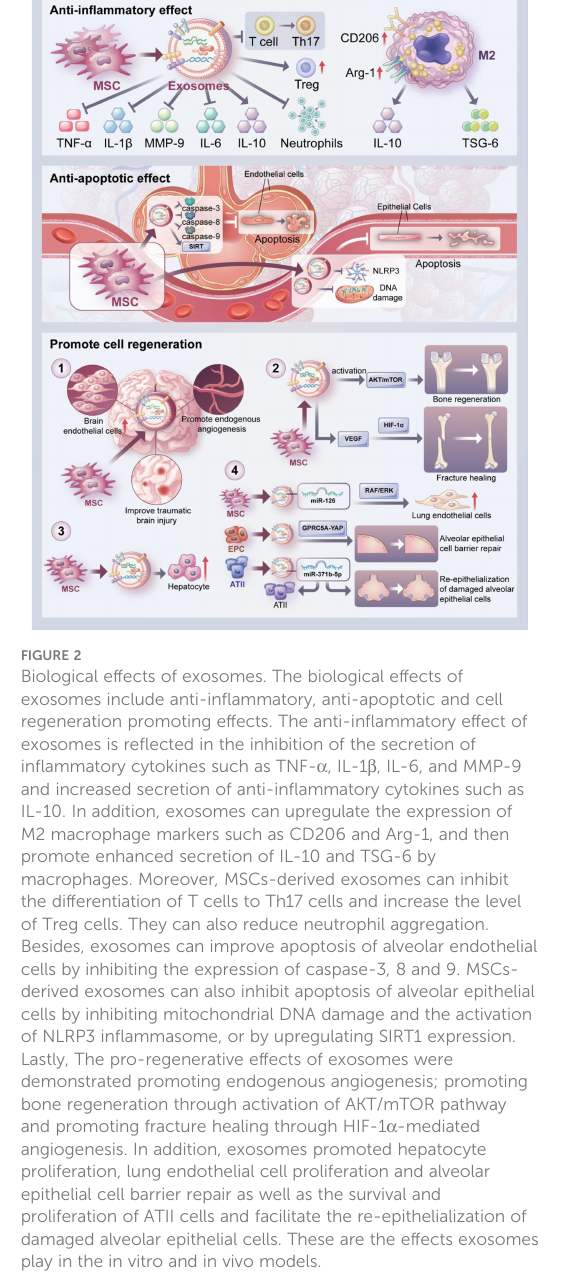
FIGURE 2 Biological effects of exosomes. The biological effects of exosomes include anti-in fl ammatory, anti-apoptotic and cell regeneration promoting effects. The anti-in fl ammatory effect of exosomes is re fl ected in the inhibition of the secretion of in fl ammatory cytokines such as TNF- a , IL-1 b , IL-6, and